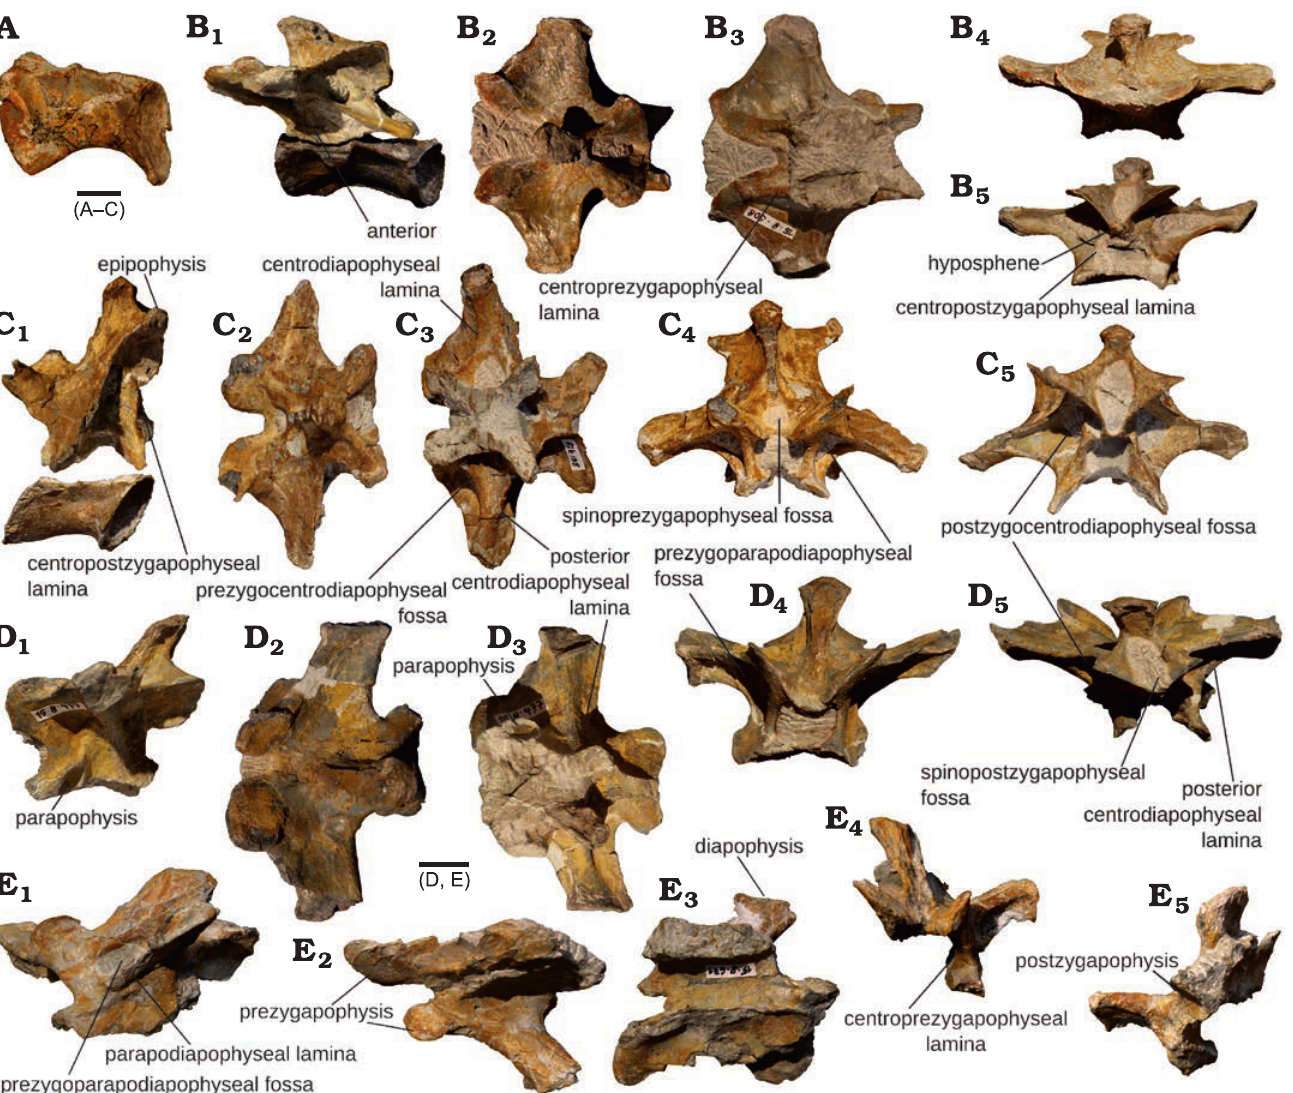
Fig. 3. Anterior dorsal vertebrae of juvenile Plateosaurus cf. trossingensis Fraas, 1913 skeleton MSF 15.8B. from the Norian of Frick, Switzerland. A . Centrum of ?dorsal vertebra 1, MSF 15.8.2003, in left lateral view. B . Dorsal vertebra 2, MSF 15.8.908 (neural arch) and MSF 15.8.978 (centrum), in left lateral (B 1 ), dorsal (B 2 ), ventral (B 3 ), anterior (B 4 ), and posterior (B 5 ) views. C . Dorsal vertebra 3, MSF 15.8.2004 (neural arch) and MSF 15.8.2005 (centrum), in left lateral (C 1 ), dorsal (C 2 ), ventral (C 3 ), anterior (C 4 ), and posterior (C 5 ) views. D . Dorsal vertebra 4, MSF 15.8.477, in left lateral (D 1 ), dorsal (D 2 ), ventral (D 3 ), anterior (D 4 ), and posterior (D 5 ) views. E . Dorsal vertebra 5, MSF 15.8.2006, in left lateral (E 1 ), dorsal (E 2 ), ventral (E 3 ), anterior (E 4 ), and posterior (E 5 ) views. Centra are only depicted in lateral view. Scale bars 10